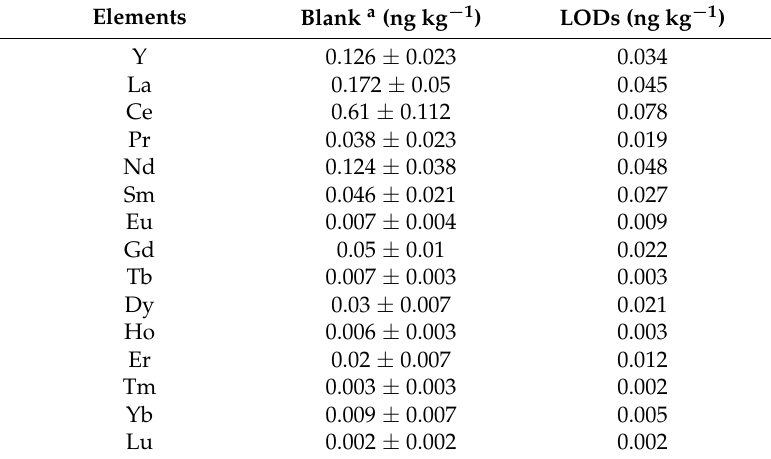
Table 2. Procedural blanks and